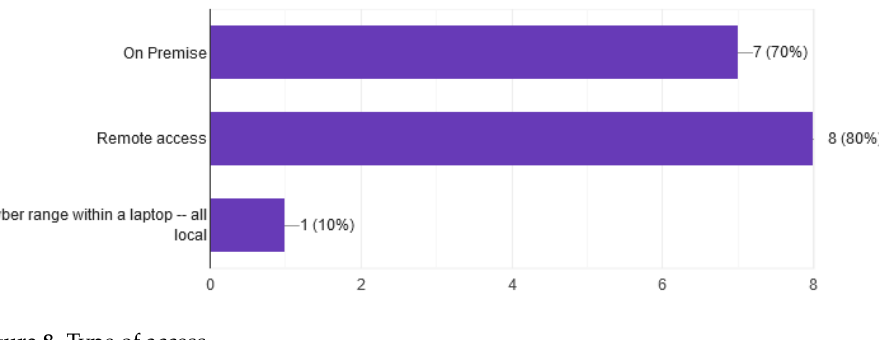
Figure 8. Type of access.